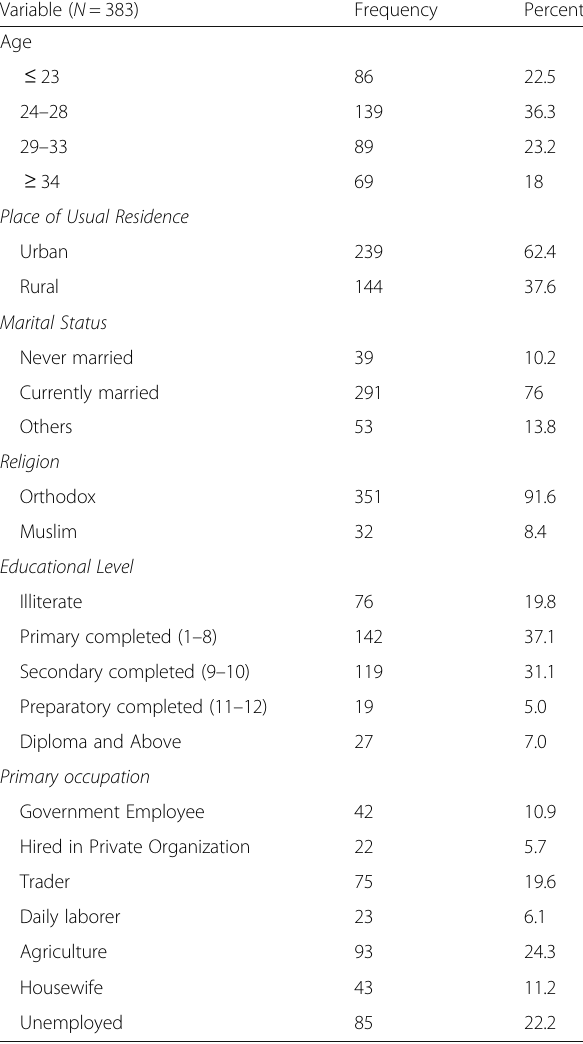
Table 1 Socio-demographic and economic characteristics of the participants; Tigray Region, Ethiopia, May,